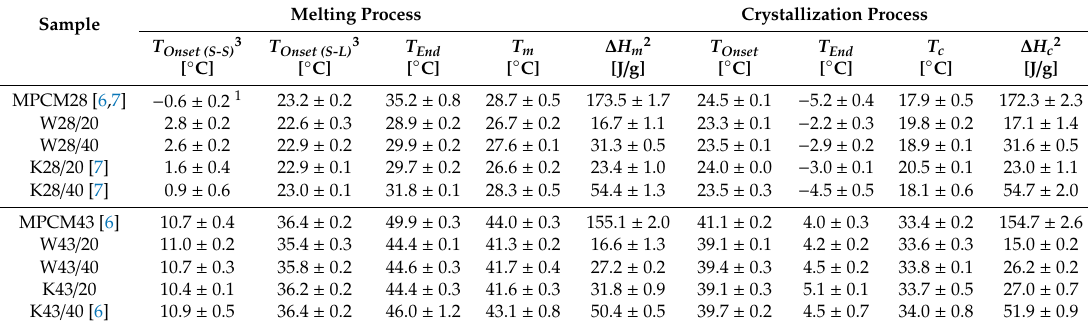
Table 1. Temperatures and enthalpies of phase transitions for MPCM powders and modified woven (W) and knitted (K)